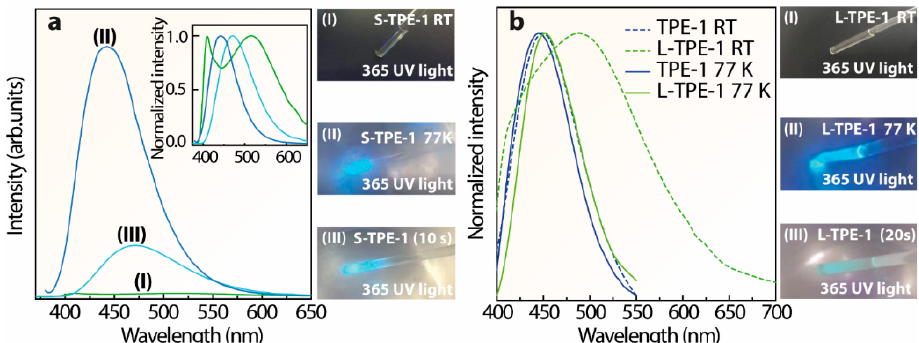
Figure 8. ( a ) Emission spectra of S-TPE-1 (10 mg/mL) measured at (I) RT, (II) 77 K (in LN), and (III) mid-state (after sinking in LN for 5 min and then exposing in the ambient environment for 10 s), accompanying with the corresponding photos, ( b ) normalized emission spectra of TPE-1 and L-TPE-1 (5 mg/mL) at RT and 77 K (in LN), illustrated with the photos of L-TPE-1 under 365 nm irradiance.